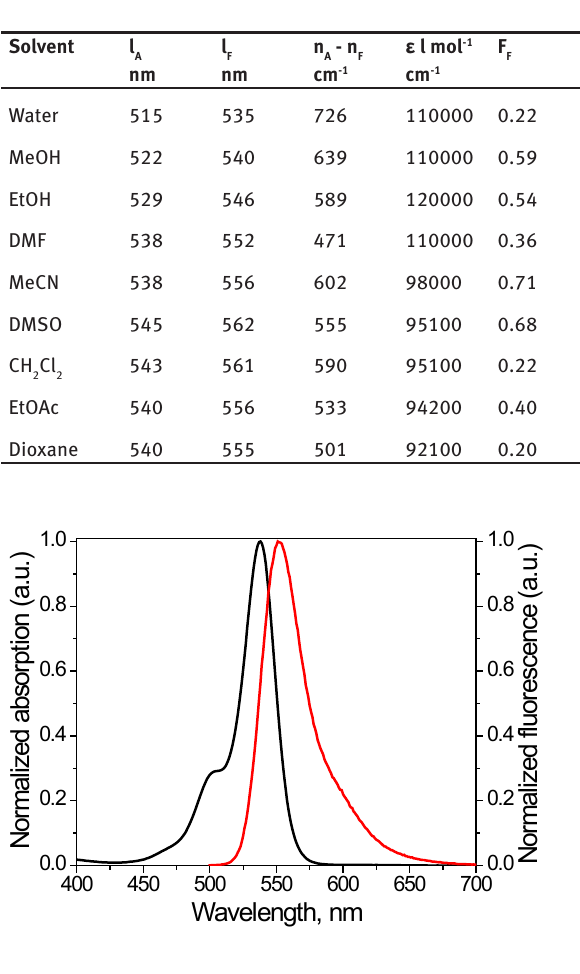
Table 1: Photophysical characteristics of compound E in solvents with different polarity.